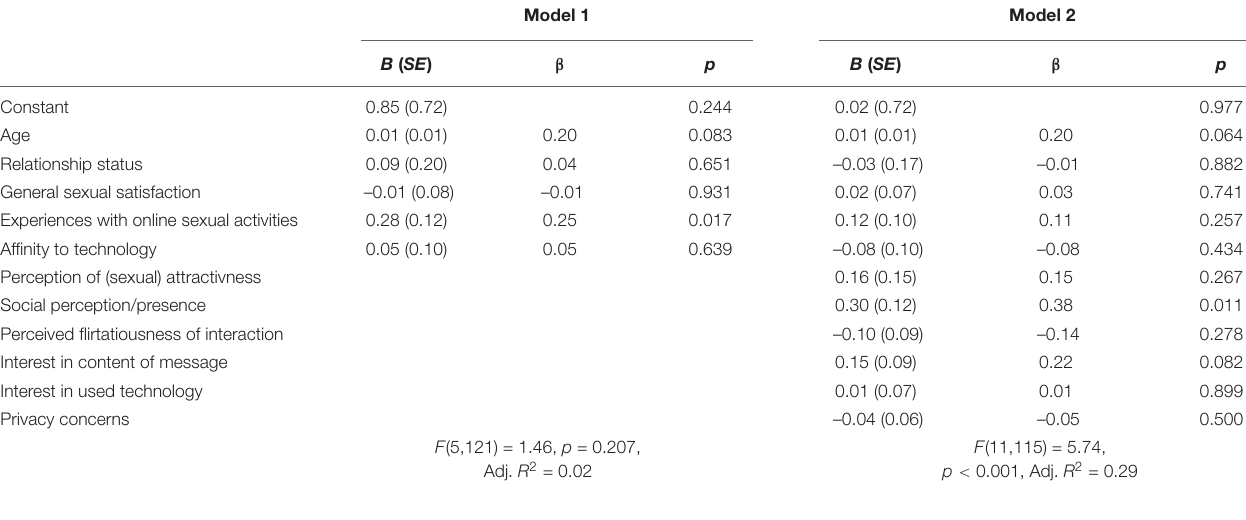
TABLE 1 | Hierarchical regression analysis of additionally heard flirtatious messages of the computer-mediated